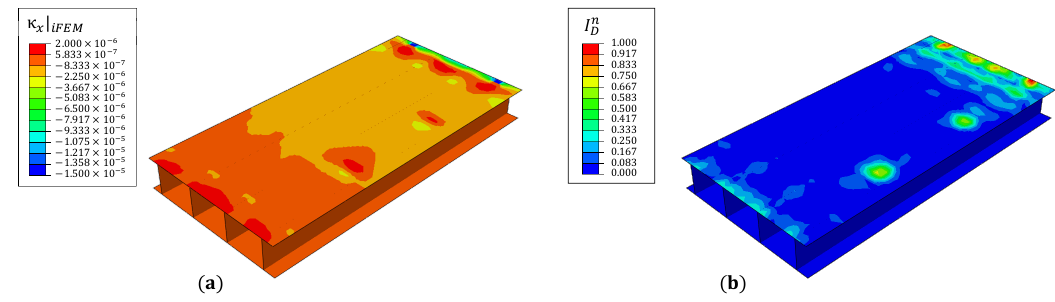
Figure 17. Contours of ( a ) iFEM reconstructed curvature and ( b ) damage index for case